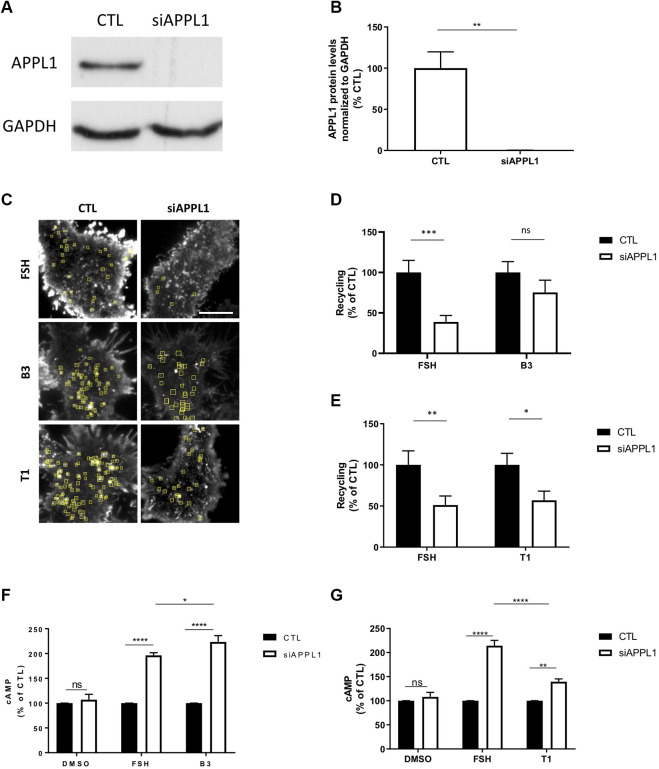
LMW compounds differentially affect APPL1-regulated FSHR recycling and cAMP signaling. (A) Western blot showing total cellular levels of APPL1 from cells treated with scramble (CTL) or APPL1 siRNA (siAPPL1). GAPDH was used as a loading control. (B) Quantification of APPL1 protein levels normalized to GAPDH protein levels from (A), and expressed as % of scramble, n = 3 independent experiments, t-test: **p < 0.01. (C) Maximum intensity projections from SEP-FSHR expressing cells imaged live by TIR-FM following transfection with either scramble (CTL) or APPL1 siRNA (siAPPL1) and stimulated with either FSH (10 nM), B3 or T1 (10 μM) for 5–20 min. Scale bar = 5 μm. (D–E) Quantification of the number of FSHR recycling events. n = 21–24 cells per condition collected across four independent experiments for (D) and n = 13–18 cells per condition collected across three independent experiments for (E). Two-way ANOVA: *p > 0.05, **p < 0.01, ***p < 0.001. (F,G) Intracellular levels of cAMP measured in cells stably expressing FLAG-FSHR following transfection with either scramble (CTL) or APPL1 siRNA (siAPPL1). Cells were stimulated with either DMSO, FSH (10 nM) or B3 (10 μM) (F) or DMSO, FSH (10 nM) or T1 (10 μM) (G) for 5 min. n = 5 (F) or 3 (G) independent experiments. Two-way ANOVA: *p < 0.05, **p < 0.001 ****p < 0.0001.